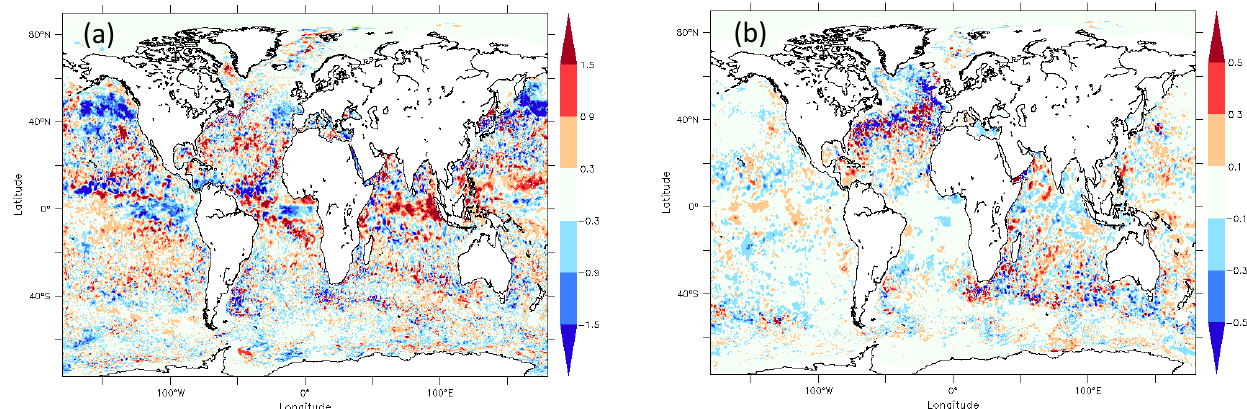
Figure 5. 19 December 2012: analyzed temperature fields – differences between Run-Ref and Run-NoArgo at 100m (a) and 1000m (b)